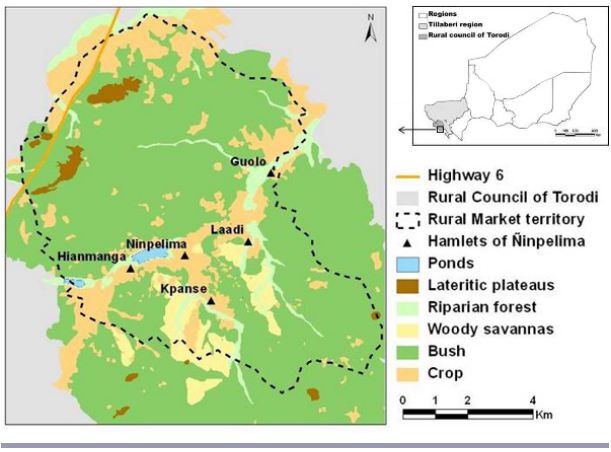
Fig. 2 . Location of the rural firewood market of Ñinpelima, and land cover of the area (Rural Council of Torodi, Say Department, Tillaberi Region).